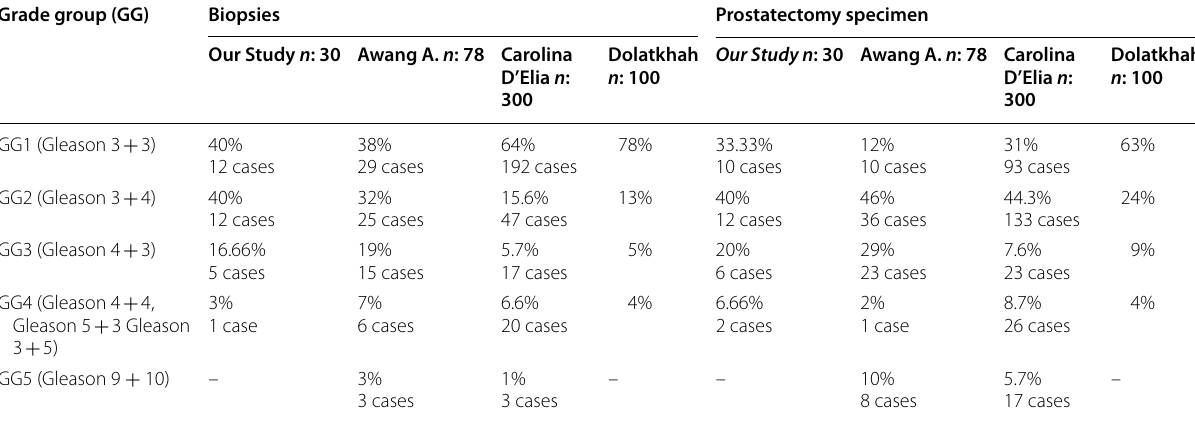
Table 2 Comparison of anatomopathological data on biopsies and prostatectomy Grade group (GG) Biopsies Prostatectomy